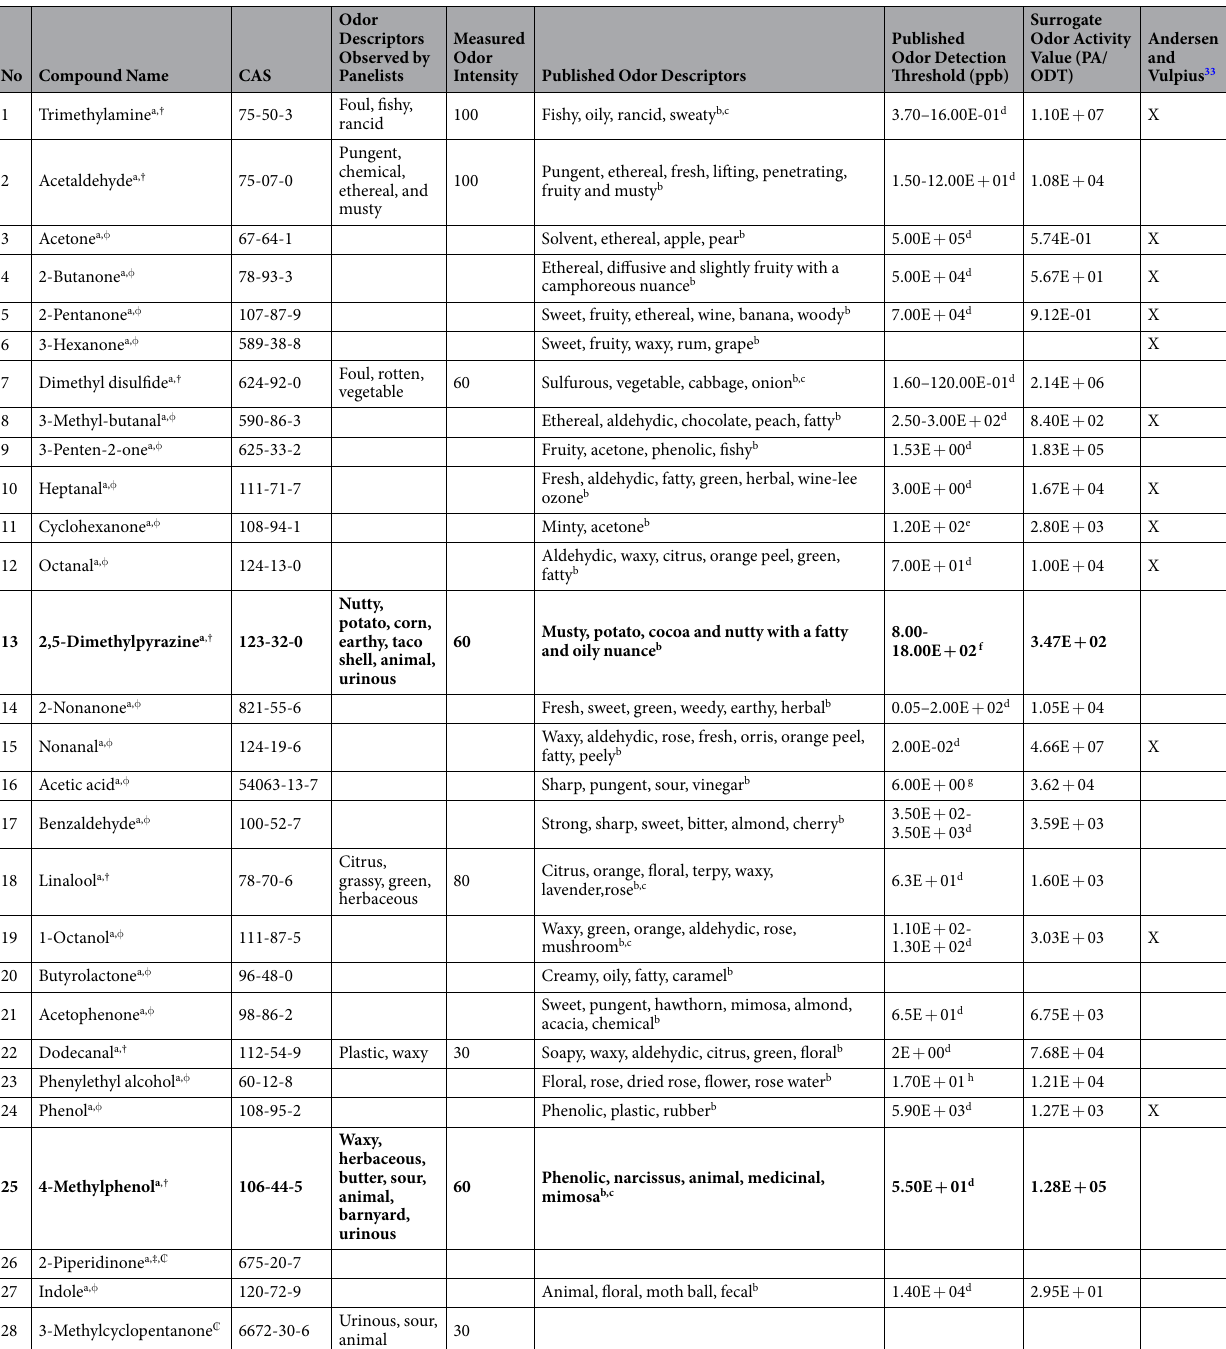
Table 1. Confirmed VOC odor and chemical composition of P. leo marking fluid. All compounds except #28 were confirmed with chemical standards. * Abbreviations: No-Number; CAS-Chemical Abstract Service Number; PA-Peak Area; ODT-Odor Detection Threshold. ** Compounds in bold are characteristic compounds. ₵ Compound does not have published odor descriptors, but odor associated with this compounds was detected by panelists. φ No odors were detected by panelists, but odor descriptors have been published for this compound. ‡ No odors were detected by panelists and no odor descriptors have been published for this compound. † Odor descriptors observed by panelists match the published odor descriptors for this compound. a Compounds verified with the retention time and ion confirmation match of standards. b Good Scents Company 98 . c Flavornet 99 . d Leffingwel 100 . e Indoor Air Quality Engineering: Environmental Health and Control of Indoor Pollutants 101 . f Detection thresholds for phenyl ethyl alcohol using serial dilutions in different solvents 102 . g Measurement of Odor Threshold by Triangle Odor Bag Method 103 . h Simultaneous chemical and sensory characterization of VOCs and semi-VOCs emitted from swine manure using SPME and multidimensional gas chromatography-mass spectrometry-olfactometry system 93